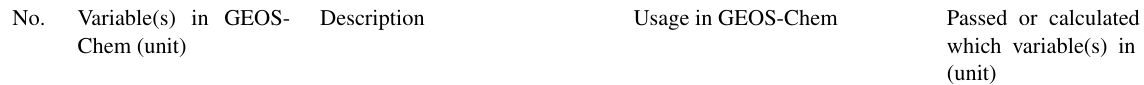
Table 1. Meteorological variables needed for GEOS-Chem.